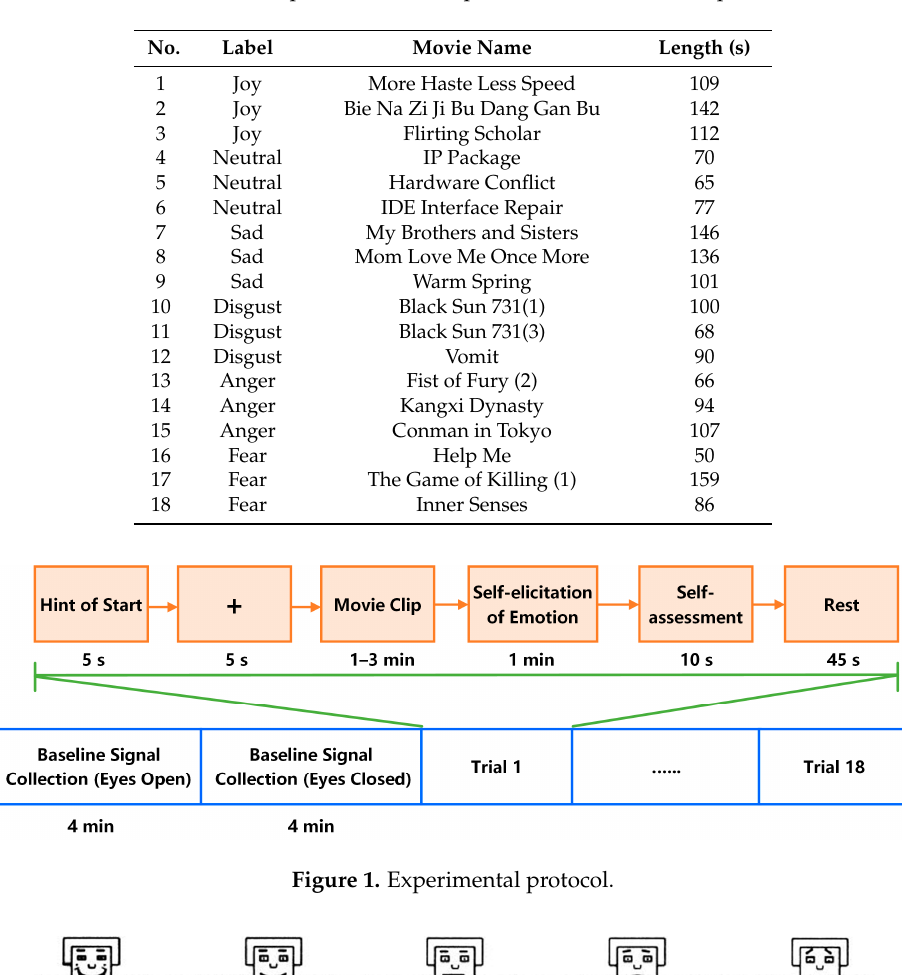
Table 1. Brief description of movie clips used in the emotion experiment.